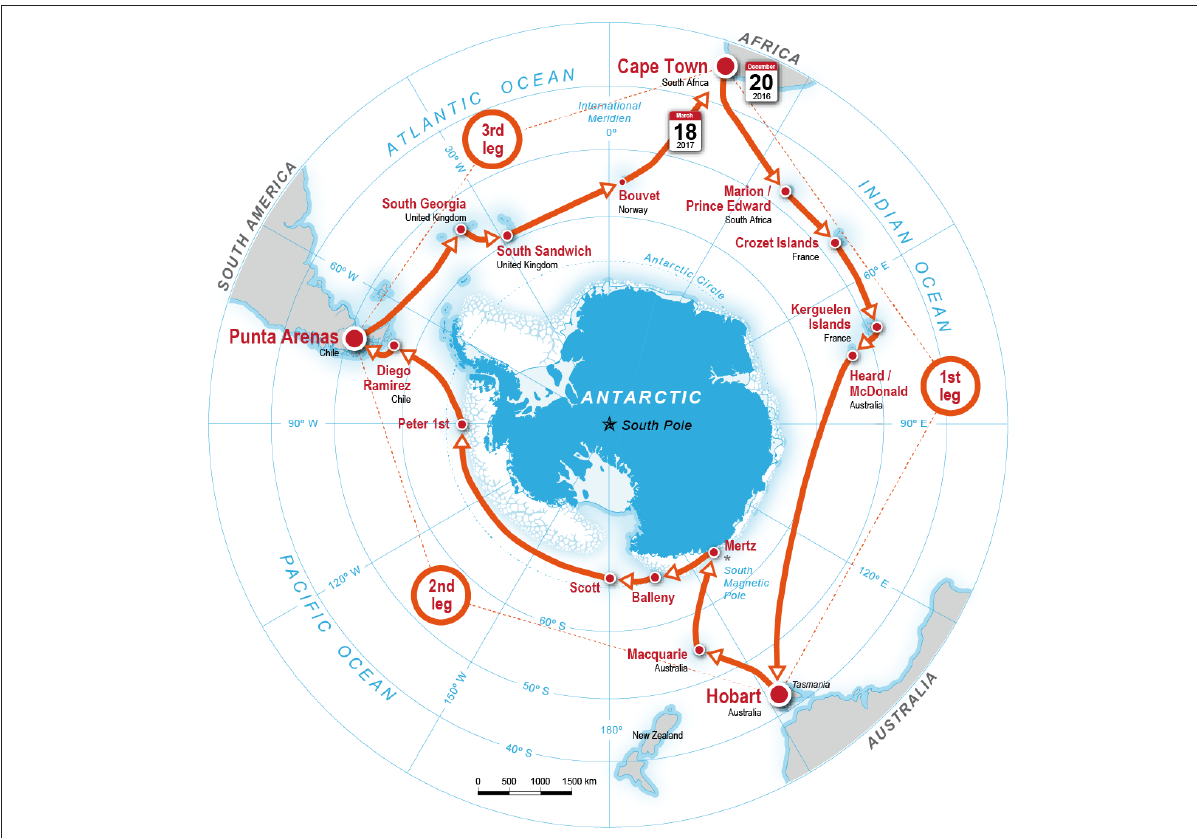
Proposed route for the Antarctic Circumnavigation Expedition (ACE), on board the R/V Akademik Treshnikov . The three legs of ACE are Cape Town to Hobart (Leg 1), Hobart to Punta Arenas (Leg 2) and Punta Arenas to Cape Town (Leg 3). The expected timeline for the cruise is 20 December 2016 to 18 March